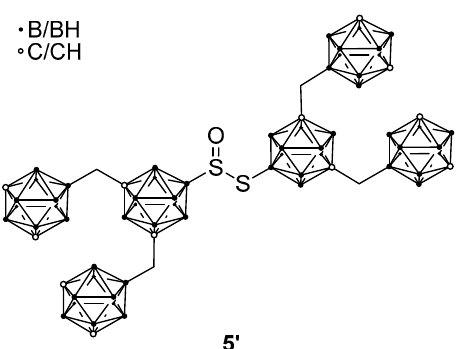
Figure 4. Mono-oxidized derivative of 1,2-bis[1,7-bis(1,7-dicarba- closo -dodecaboran-9-ylmethyl)-1,7- dicarba- closo -dodecaboran-9-yl]disulfane ( 5 ′ ).